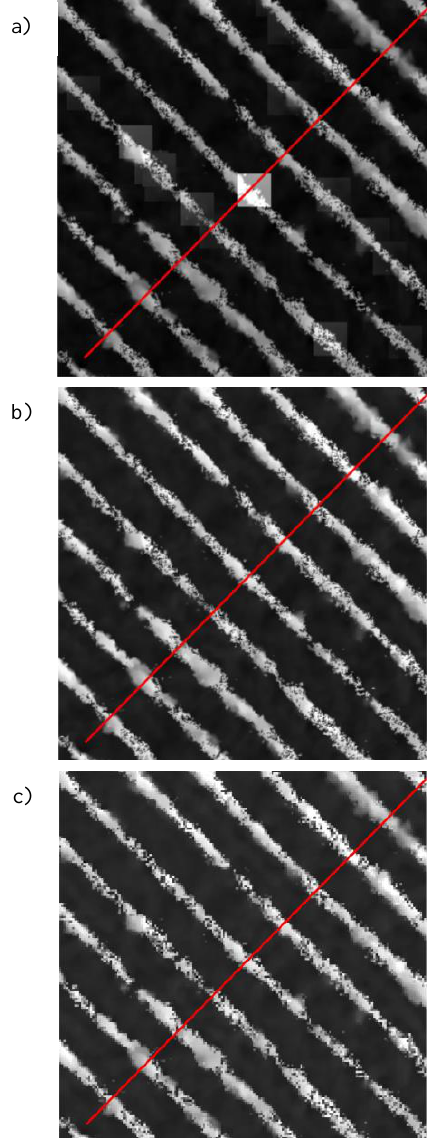
Figure 8: Differential model of the vine rows obtained by subtracting the DTM to the DSM. a) Using a minimal filter. b) Using a 1 percentile filter. c) Using a 5 percentile